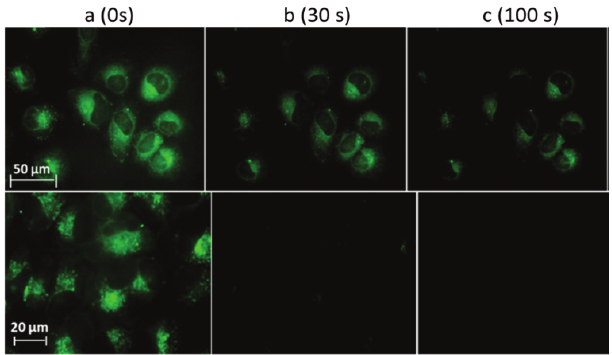
Figure 24. Photobleaching experiments of HeLa cells incubated with compound 28a ( top ) or LysoTracker Green DND-26 ( bottom ) after exposure to the green light ( λ ex = 414 nm), continuously, during: ( a ) 0 s, ( b ) 30 s, and ( c ) 100 s. Adapted from [65].